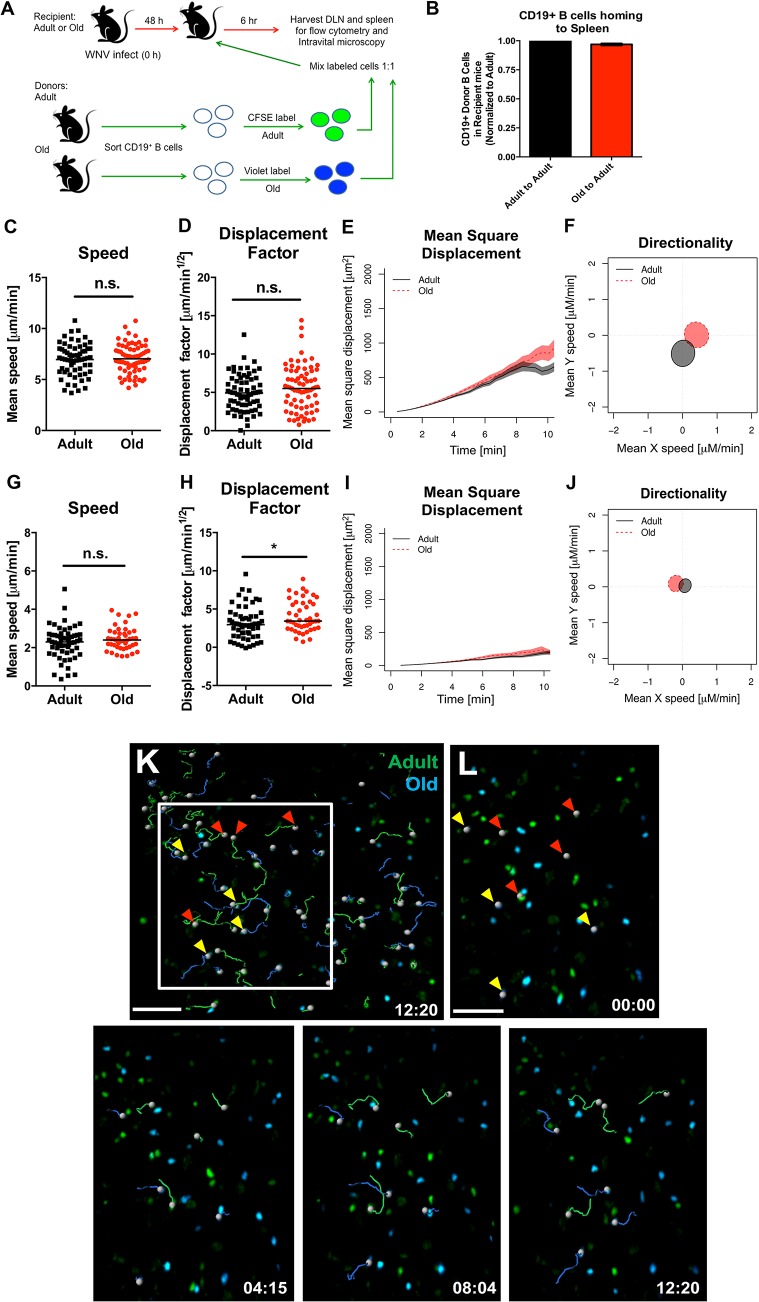
Normal migration of CD19+ B cells from old mice.
A. Scheme of adoptive transfer studies of CD19+ B cells. 5 x 106 isolated B cells from adult or old mice were differentially labeled with fluorescent dyes, mixed in a 1:1 ratio, and transferred to recipient adult mice infected with WNV-KUN 48 hours earlier via a subcutaneous route. B. Six hours later, spleens were harvested. Cells were counted and the frequency of adult and old donor cells was determined by flow cytometry. The data was normalized to the levels of adult donor cells in the recipient organ and is a composite of two independent experiments. C-J. Analysis of movement parameters of adult and old donor naïve CD19+ B cells in explanted LN (C-F) or spleen (G-J) 6 hours post-transfer to recipient mice that had been infected with WNV-KUN 48 hours earlier. Individual cells were tracked and (C, G) speed (μM/min), (D, H) displacement factor (μm/min1/2), (E, I) mean square displacement over time, and (F, J) directionality (Hotelling’s test) were determined. The data in C, D, G, and H are shown as a scatter plot and reflects two independent experiments. n.s. indicates the differences were not statistically significant; * indicates P < 0.05, Mann-Whitney test. K-L. Time-lapse image sequences of transferred adult and old CD19+ B cells in explanted LN in recipient mice 48 h after WNV-KUN infection. Differentially labeled (blue = old, green = adult) CD19+ B cells were adoptively transferred into WNV-KUN infected adult recipient mice (48 h after infection) and DLN were harvested 6 to 8 h later followed by ex vivo imaging. Panel K presents all tracked adult and old cells during the first 12 minutes within the cropped area with the white frame. Panel L and others presents time-lapse image sequences of adult and old cell tracking during first 12 minutes. Yellow and red arrows indicate which old and adult cells were analyzed and their starting points, respectively. Scale bar is indicated in white. Images are individual frames from a continuous time-lapse movie (S4 Movie).